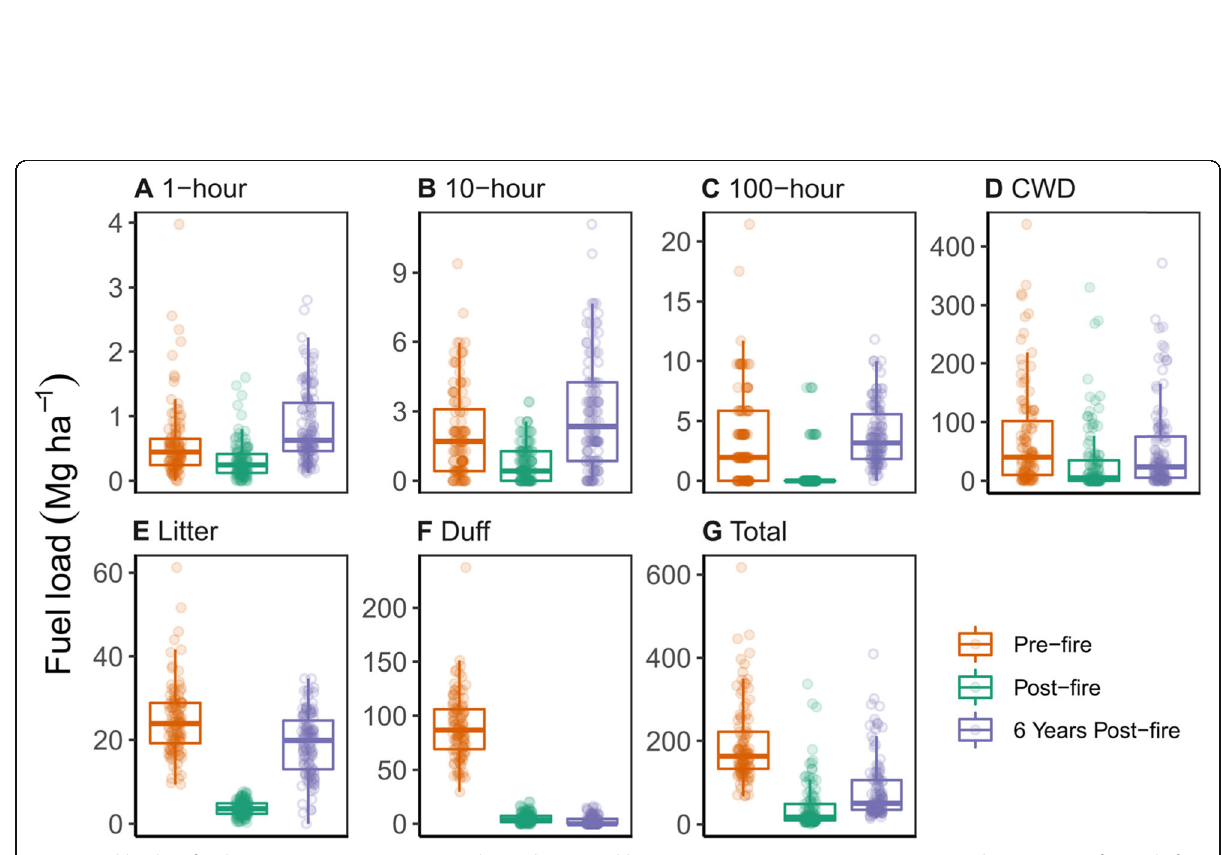
Fig. 6 Fuel loading for the Yosemite Forest Dynamics Plot as determined by 112, 20-m Brown ’ s transects (2240 m total) in 2011, pre-fire and after a century of fire exclusion, in 2014, immediately post-fire, and in 2019, 6 years post-fire. Heterogeneity in fuel loading among transects is represented by the interquartile range and 95% outer confidence limits represented by the box and whiskers; the median value is the solid line bisecting the box. Brown ’ s transect data was used to survey all surface fuel pools; other figures display only those fuels above the 1000-h diameter threshold. CWD, coarse woody debris ( ≥ 7.62 cm